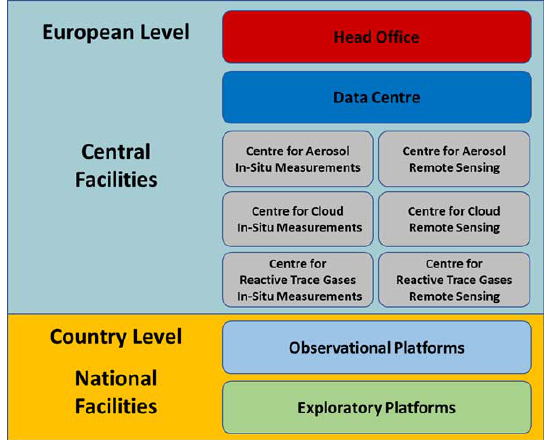
Figure 1: ACTRIS structure consisting of eight Central Facilities operated at European level and National Facilities comprising Observational and Exploratory Platforms operated at the national